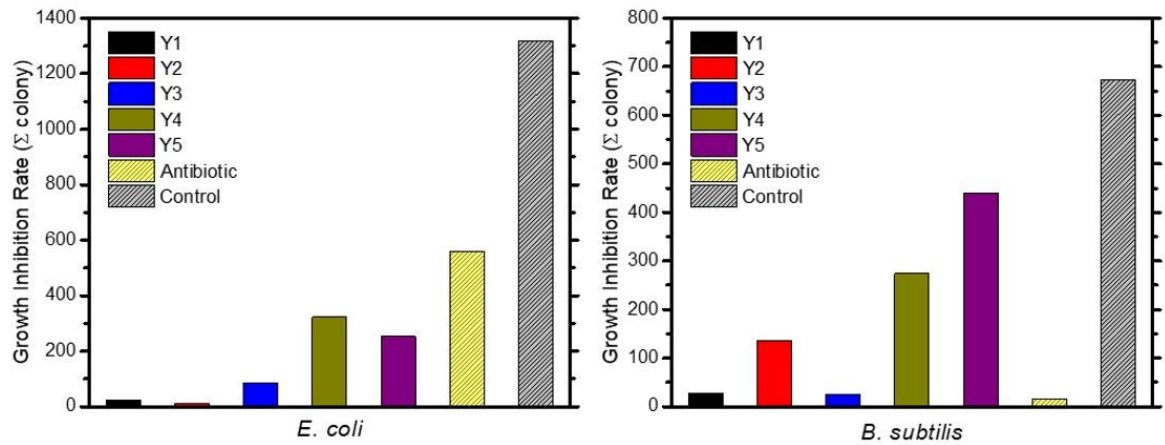
Figure 7. Antibacterial activity of the Zn-doped aqueous magnetite ferrofluids on E. coli (left-hand side) and B. subtilis (right-hand side)